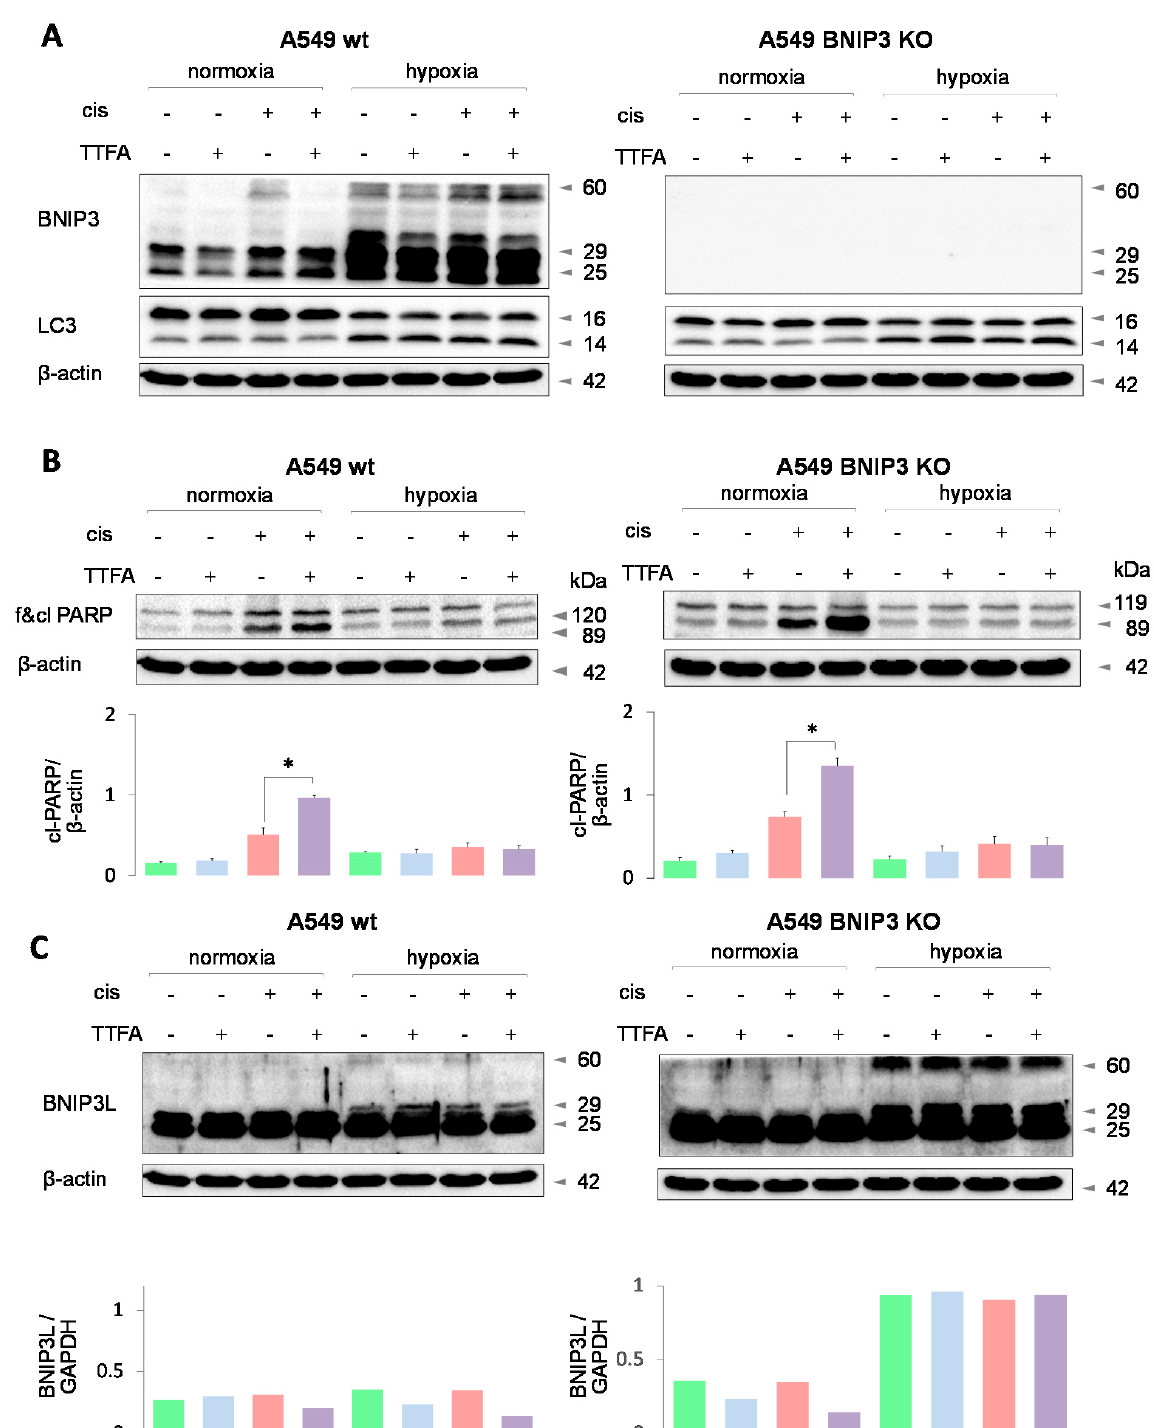
Figure 5. The consequences of BNIP3 knockout for cell death induction by cotreatment with cisplatin and TTFA under normoxic and hypoxic conditions in A549 lung adenocarcinoma cells. Assessment of LC3 content in WT and BNIP3 KO A549 cells ( A ), assessment of apoptotic PARP cleavage in WT and BNIP3 KO A549 cells ( B ), accumulation of BNIPL dimers in BNIP3 KO A549 cells ( C ). * p < 0.01.